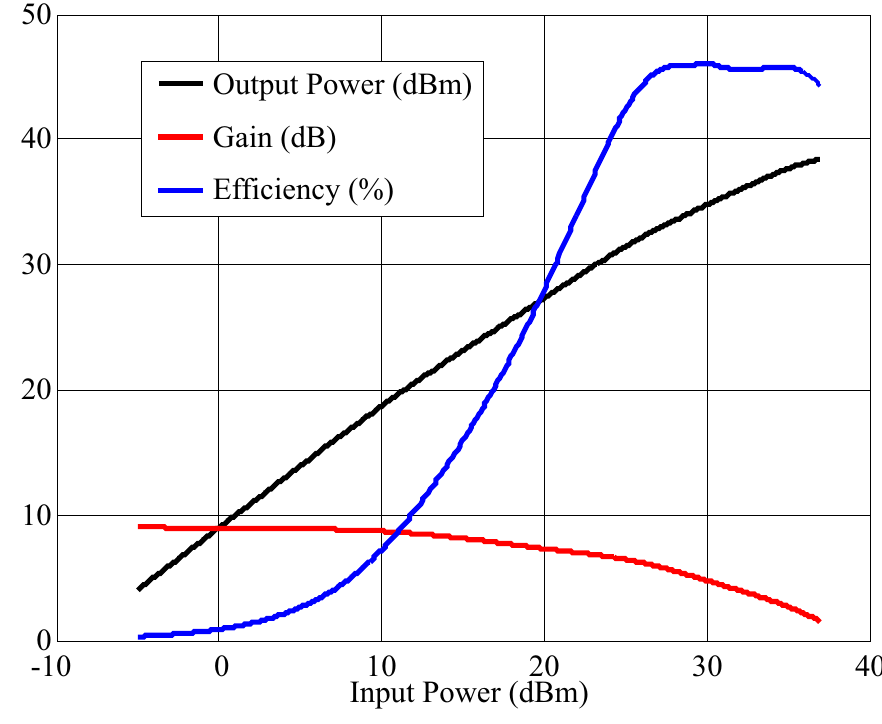
Figure 6. Simulated performances at 7 GHz of the experimental foundry Doherty PA. Output power, power gain, and efficiency vs. input